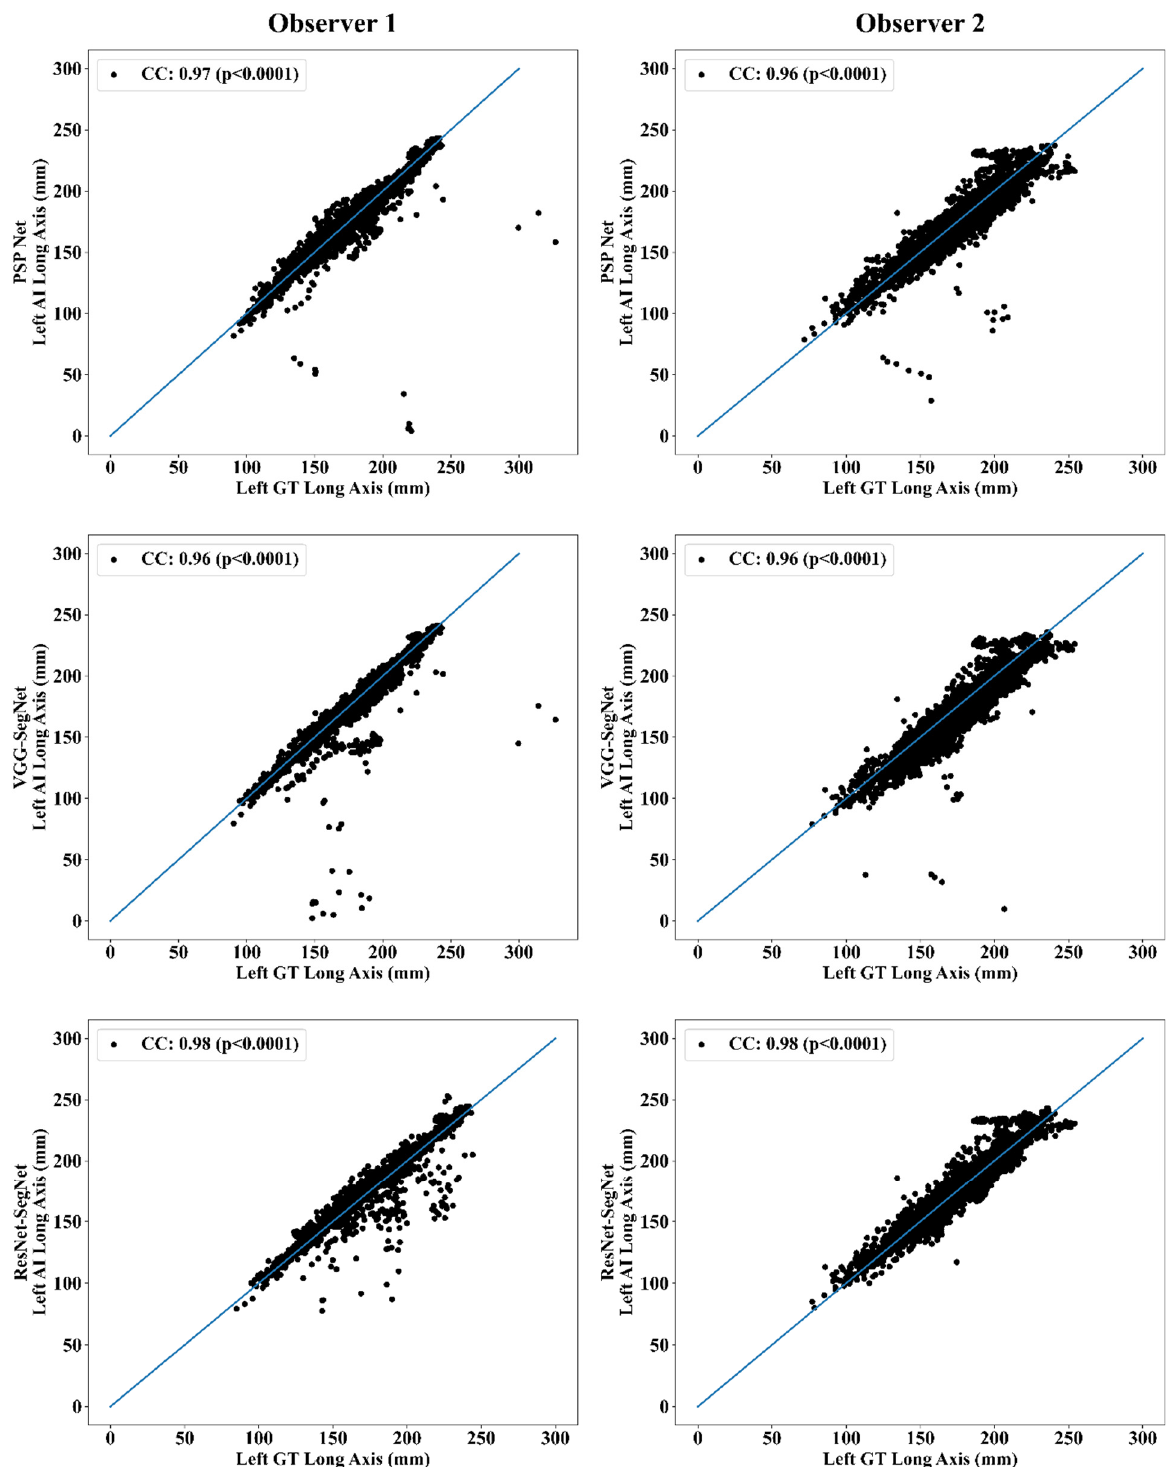
Figure 23. CC of left LLA for three AI models: Observer 1 vs. Observer 2.